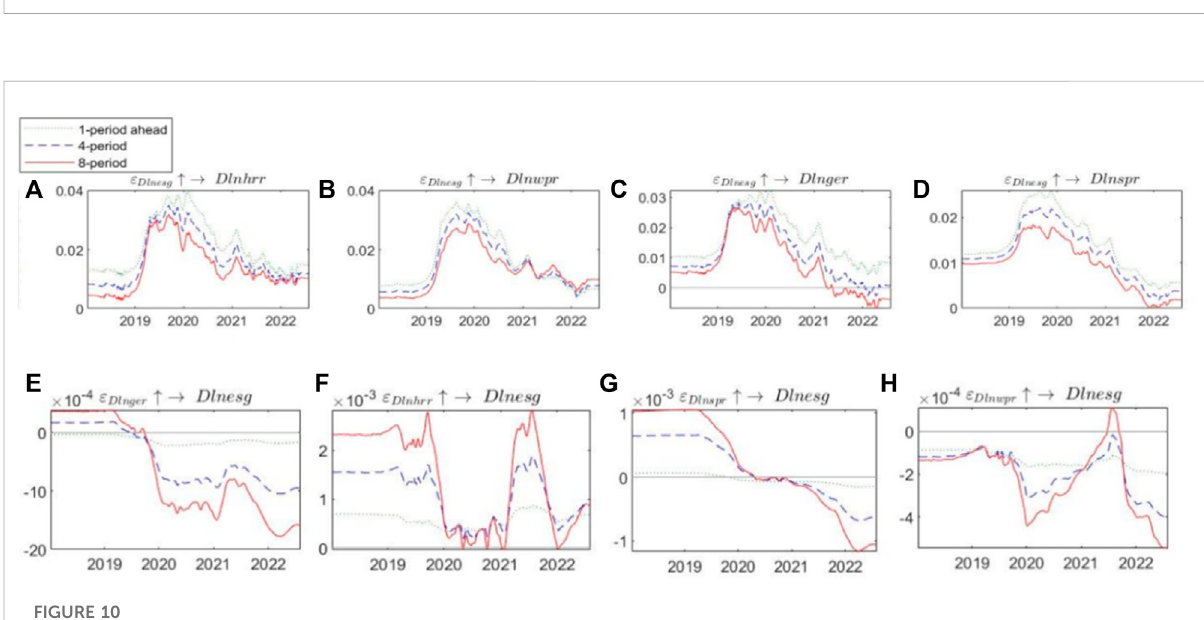
FIGURE 10 Equally spaced impulse response function graphs. The isometric impulse responses of sustainable development to (A) geothermal, (B) hydro, (C) solar, and (D) wind energy, (E) the iso-interval impulse response of the geothermal energy shock to sustainable development, (F) the iso-interval impulse response of hydro energy shocks to sustainable development, (G) theiso-interval impulse response of solar energyto sustainability, and (H) the equally spaced impulse response of wind energy to sustainable